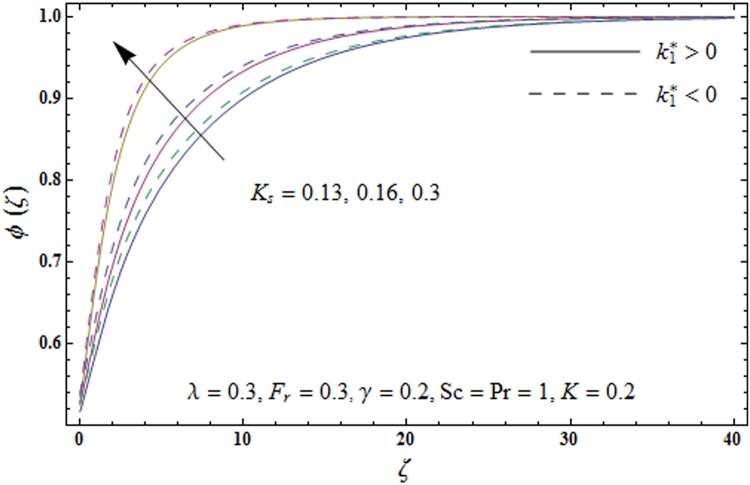
Plots of concentration field ϕ(ζ) for strength of heterogeneous reaction Ks.